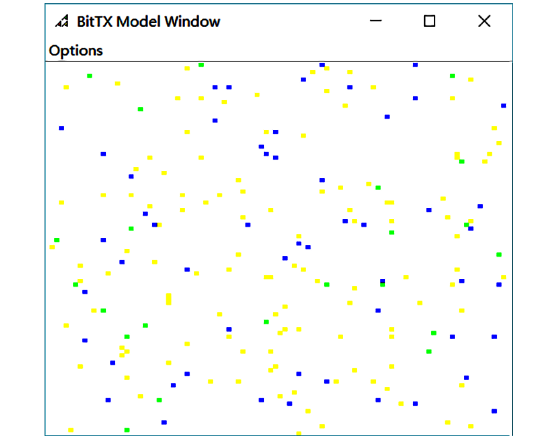
Figure 6. Running